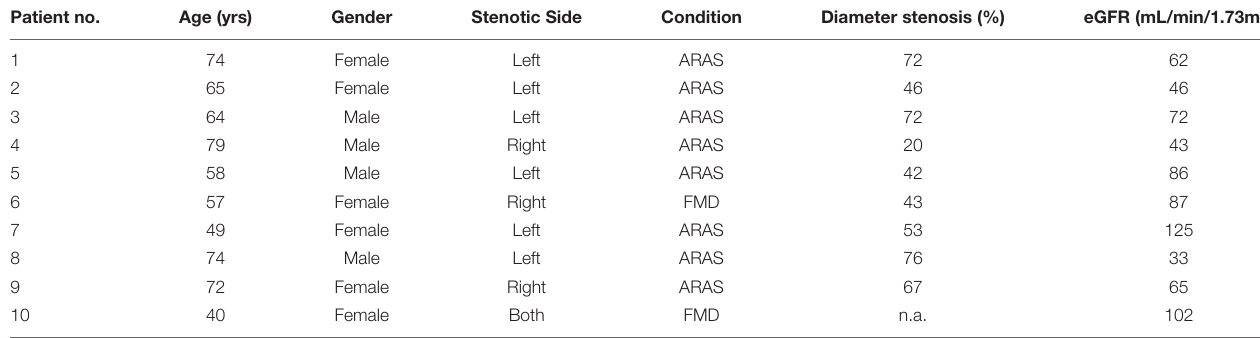
TABLE 1 | Patient Characteristics.